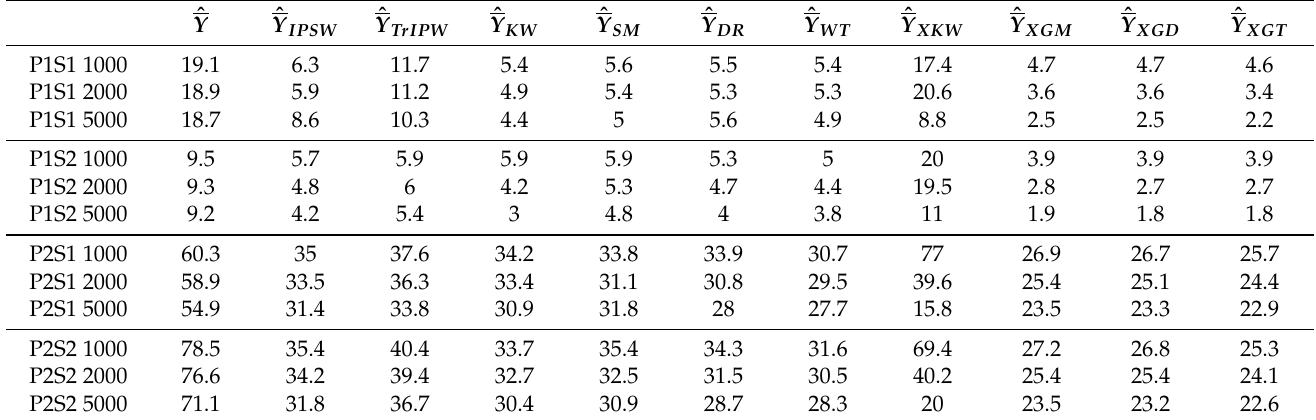
Table 2. Relative RMSE (%) for each real population